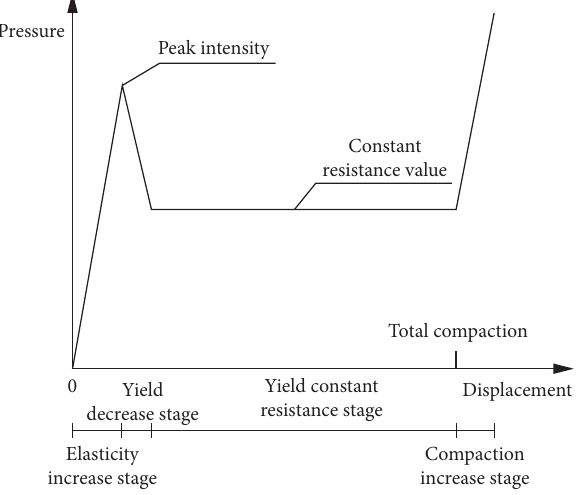
Figure 6: Simplified loading-deformation curve of SRLD.